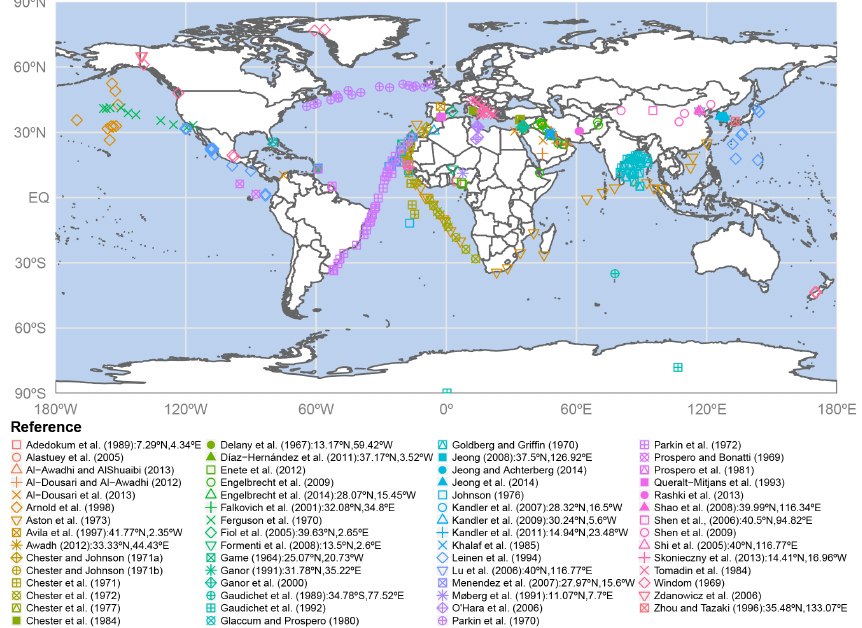
Figure 1. Locations of measured mineral fractions compiled from the literature used for the evaluation of the simulations. References with geographical coordinates in the legend provide measurements only for this single location; otherwise, references provide measurements for multiple locations. See Table 1 and Table S1 in the Supplement for more